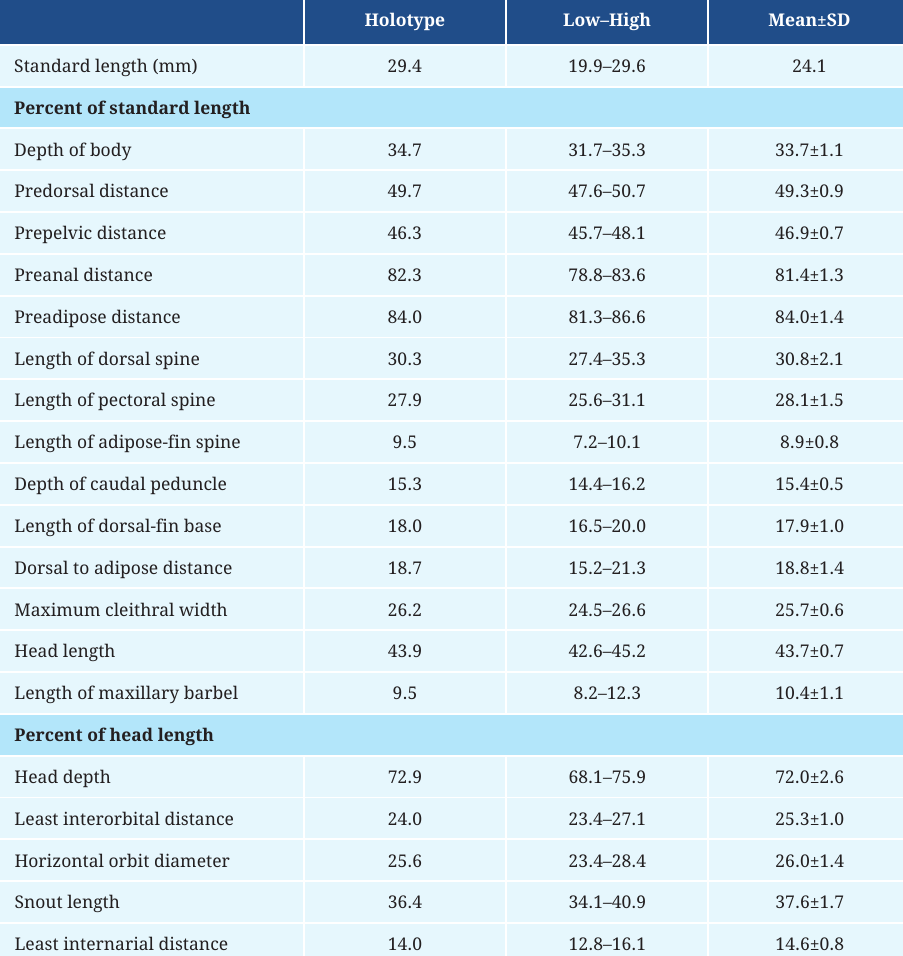
TABLE 3 | Morphometric data of the holotype and 19 paratypes of Corydoras psamathos . SD = Standard